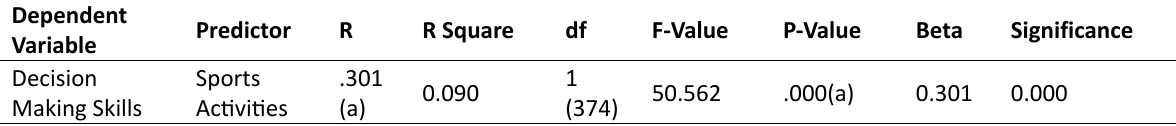
Table 3. Linear regression model showing influence of predictor upon criterion variable Dependent